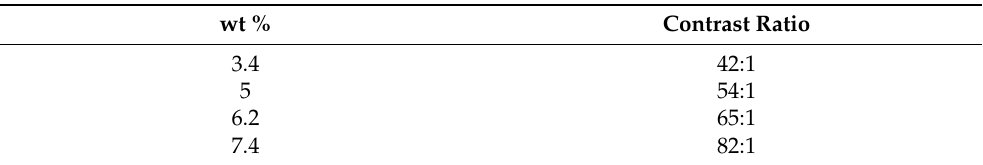
Table 5. Light luminance and calculated contrast ratio of the polarized mode transparent OLED display as a parameter of the dye concentration at 5.6 µ m of the cell gap. Light luminance in the OLED area was measured as 2162 cd/m 2 .